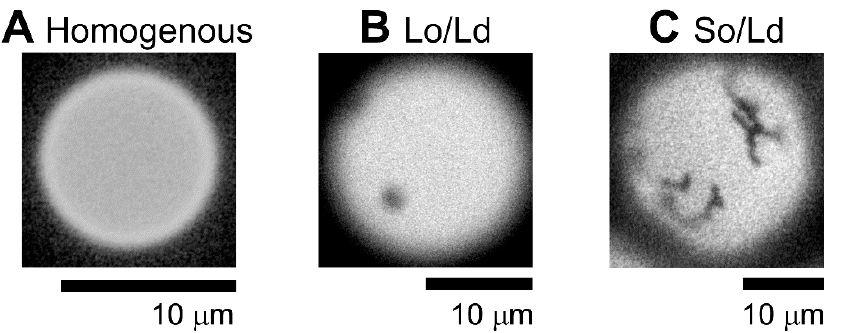
Figure 3. Representative microscopic images of multicomponent liposomes made with cholesterol as the sterol component, featuring three different phase-separated lipid domains. ( A ) Homogenous (DPPC:DOPC:Chol, 40:40:20), ( B ) Lo/Ld (DPPC:DOPC:Chol, 40:40:20), and ( C ) So/Ld